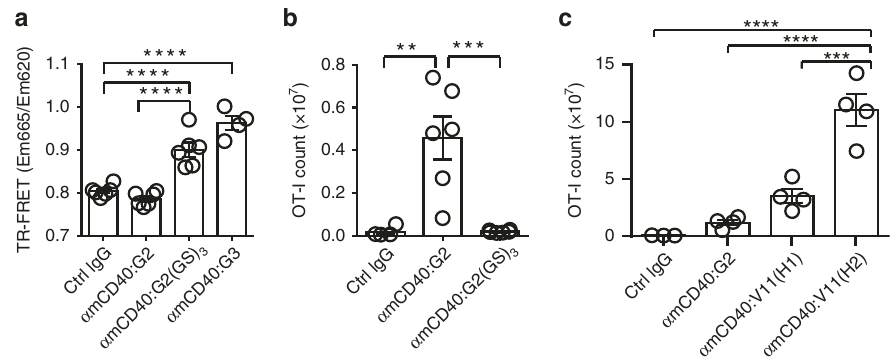
Fig. 6 The synergy between Fc γ RIIB-binding Fc and rigid CH1-hinge. a Relative TR-FRET signal levels of anti-mCD40 antibodies of indicated constant domains (G2(GS) 3 is a human IgG2 constant domain variant with a “ GSGSGS ” insertion in the hinge (Supplementary Table 2)) quanti fi ed as in Fig. 4c – e. b , c Quanti fi cation of OT-I cells in Fc γ R-humanized mice treated and analyzed as in Fig. 1a, together with indicated control or anti-mCD40 antibodies of indicated constant domains (10 μ g per mouse). Numbers of mice: b four to six mice per group; c three mice for ctrl IgG and four mice for each other groups. In b , c , each symbol represents an individual mouse. Bars represent the mean ± SEM. ** p ≤ 0.01, *** p ≤ 0.001, **** p ≤ 0.0001, one-way ANOVA with Holm – Sidak ’ s post hoc. Source data ( a – c ) are provided as a Source Data fi le. A representative of two independent experiments is